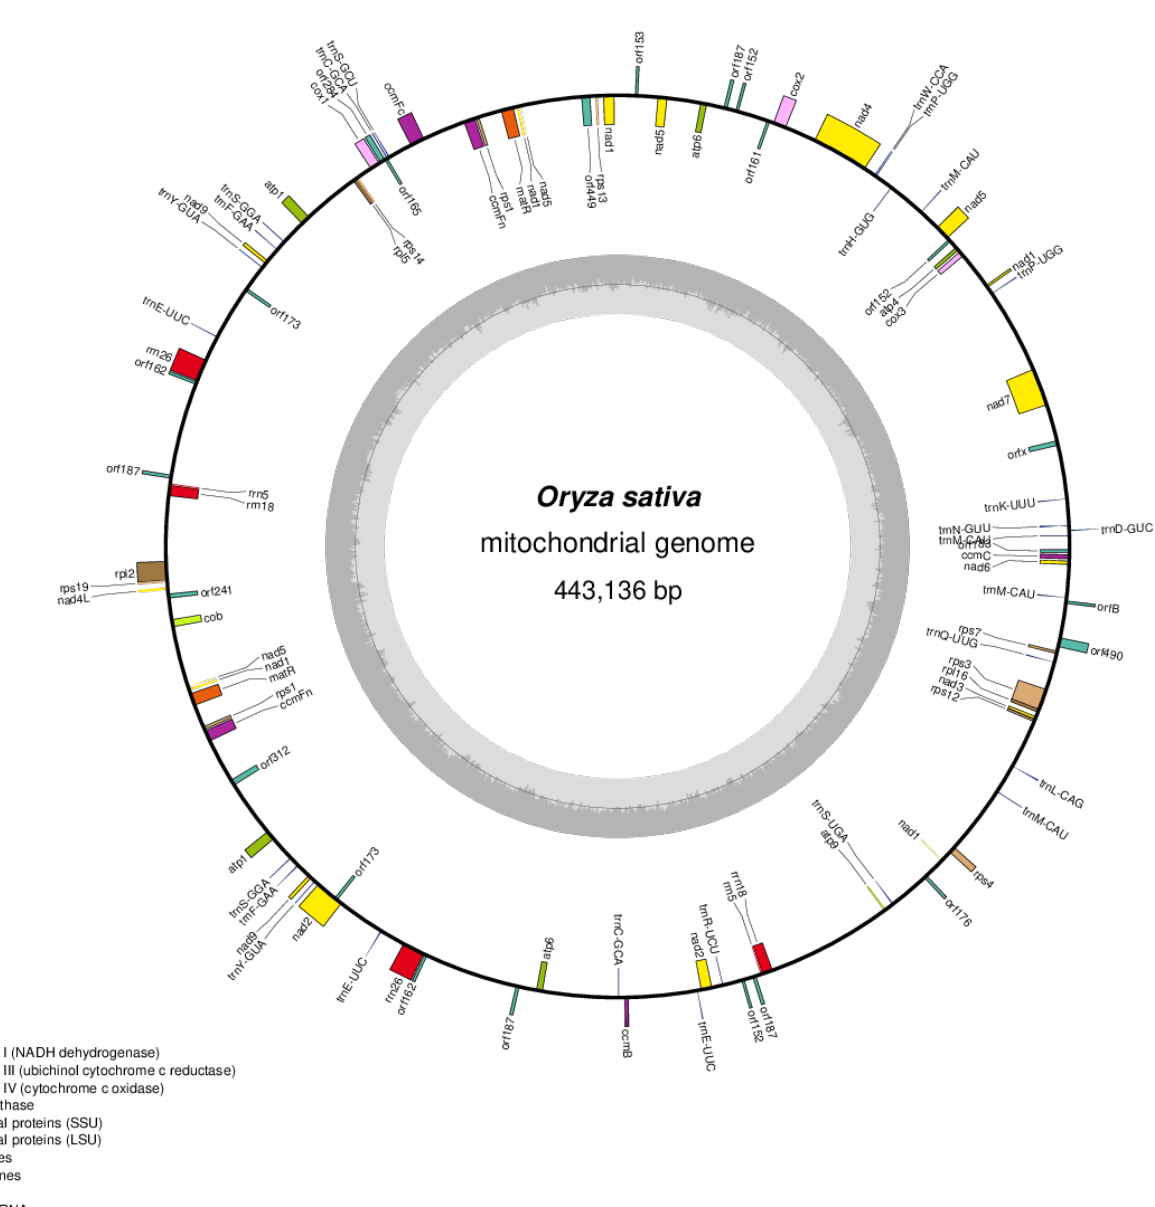
Figure 2. Physical map of mitochondrial genomes for Tetep-CMS line Hopum A. The outer circle represents the physical map. The genes on the inside (clockwise) or the outside (counter-clockwise) of the outer circle represent the transcription direction. Different colors indicate different genes as defined in the legend shown in left bottom of the figure. Complex Ⅰ , Ⅱ , Ⅲ , Ⅳ ; ATP synthase; ribosomal proteins; maturases; other genes; ORFs; transfer RNAs and ribosomal RNAs. The plant mitochondrial genome size varies within species [43]. Thirteen sequenced mitochondrial genomes in rice, including japonica , indica, and O. rufipogon varied in size ranging from 401,567 to 637,692 bp. Characterization of the mitotype can help to under-